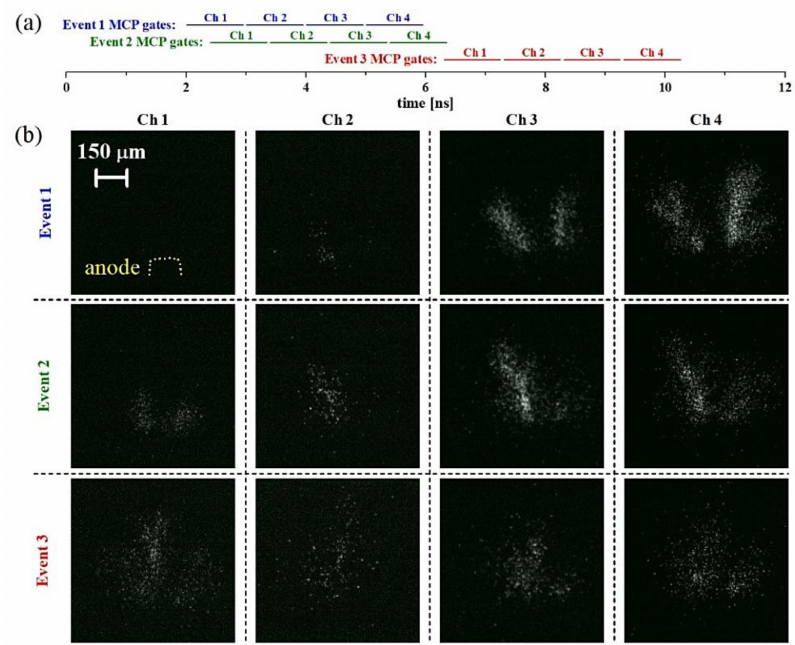
Figure 7. Case study A; image sequences obtained with the discharge emission that passes through the λ c = 656 nm interference filter. Horizontal bars in ( a ) labelled as Ch1–Ch4 illustrate timing of the Ch1–Ch4 MCP gates with respect to the onset (time t = 0 ns) of the HV pulse. Images in panel ( b ) show the evolution of selected events during the primary HV pulse acquired by using equal Ch1–Ch4 MCP gates of 1